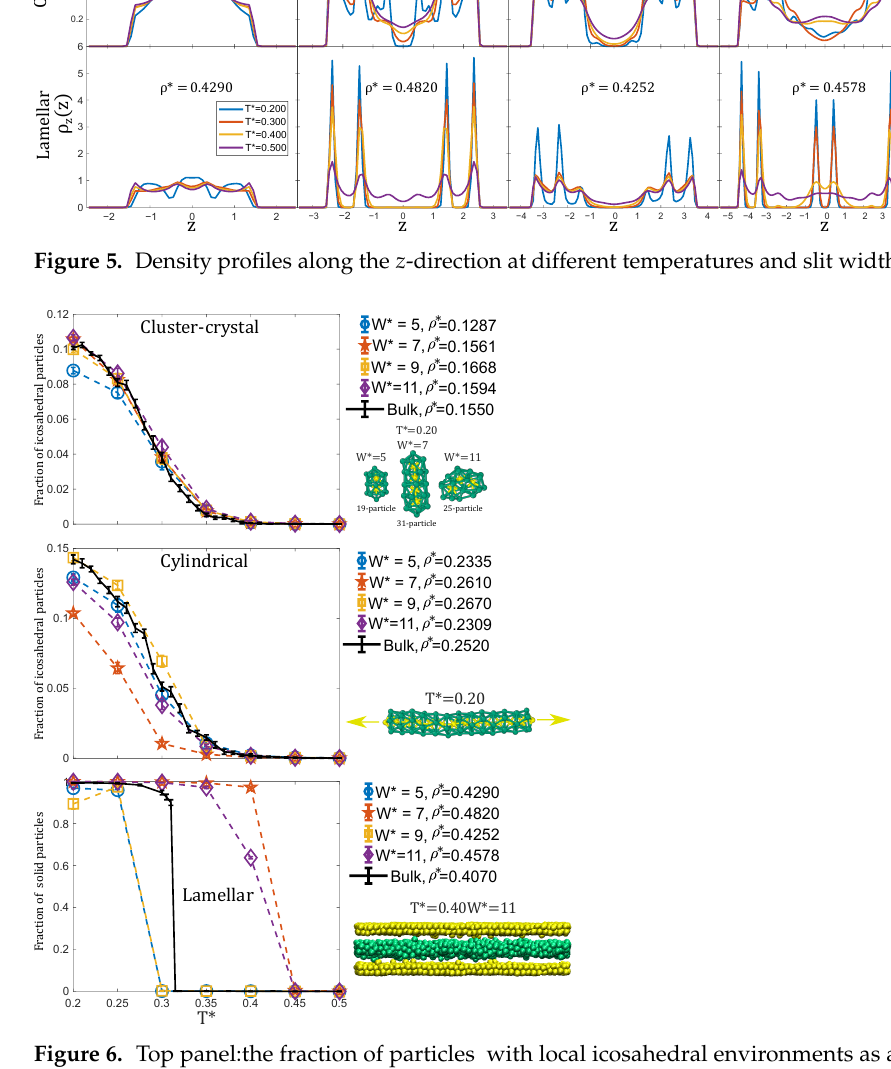
Figure 6. Top panel:the fraction of particles with local icosahedral environments as a function of temperature for the bulk and the confined systems at a low density at which the cluster-crystal phase is stable. Central panel: the fraction of particles with local icosahedral environments as a function of temperature for the bulk and the confined systems at an intermediate density at which the cylindrical phase is stable. Bottom panel: the fraction of particles within a hexagonal local environment as a function of temperature for the bulk and the confined systems at a high density at which the lamellar phase is stable. Note that the classification of particles in these plots is based solely on analysis of the local structure around each particle; the dynamics of the particles was not taken into account in this